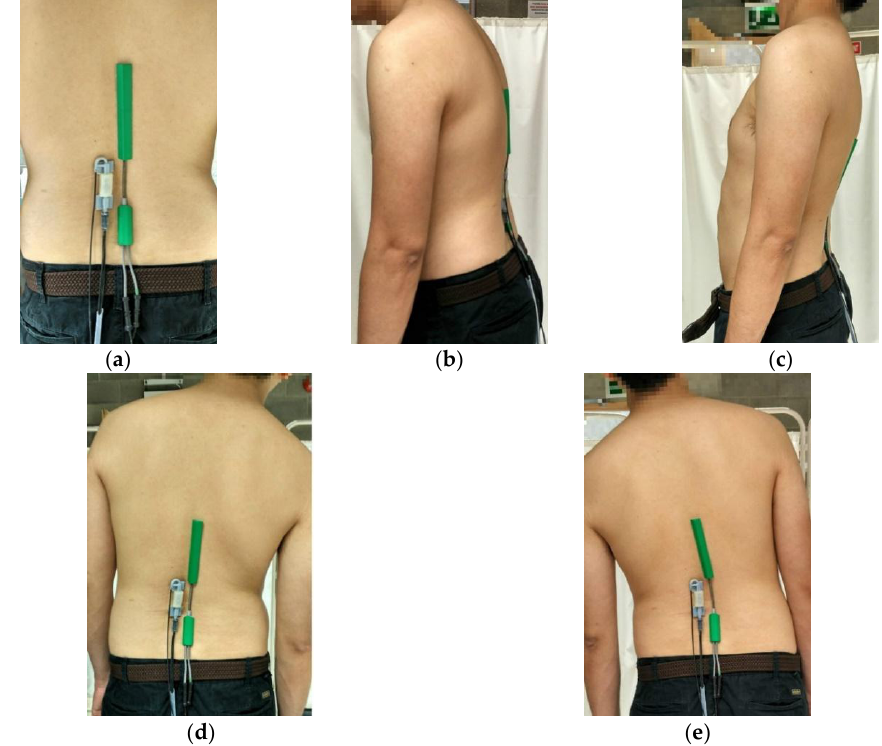
Figure 2. ( a ) Participant in a reference standing position having the POF sensor and Biometrics goniometer firmly attached next to each other on the skin at the low back-location. ( b ) Participant in the position for measuring flexion angle. ( c ) Participant in the position for measuring extension angle. ( d ) Participant in the position for measuring lateral bend (right) angle. ( e ) Participant in the position for measuring lateral bend (left) angle.